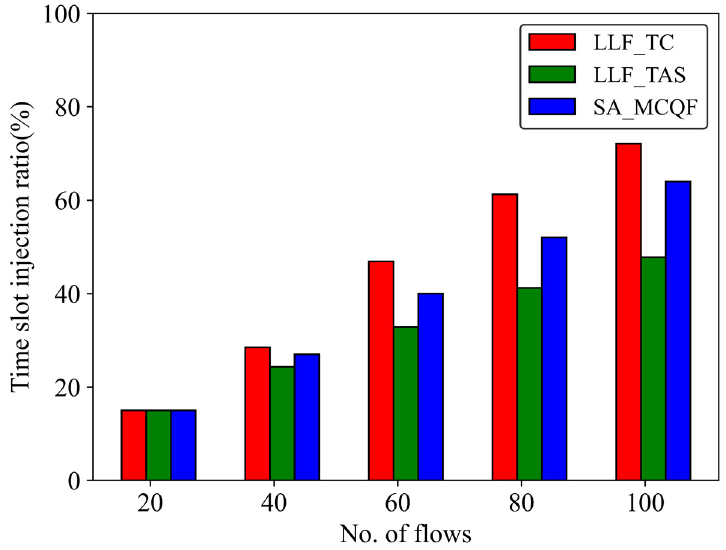
Figure 11. Time slot injection ratio under different scheduling mechanisms.